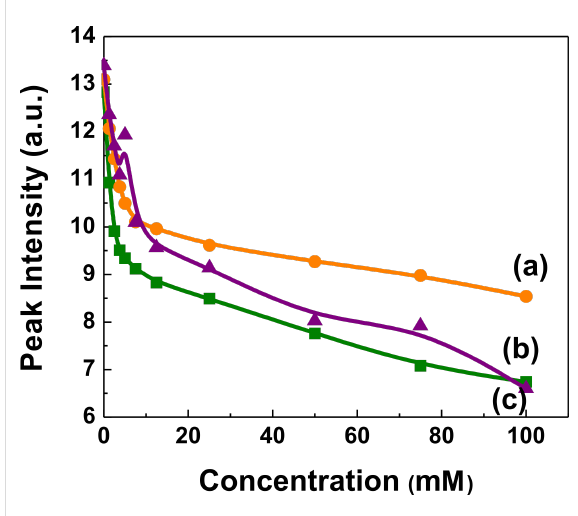
Figure 7: Stern–Volmer plots of (a–c) P3HT:CISe, P3HT:CIGSe, and P3HT:CZTSe nanocomposites. kinds of fluorophores, one of which is accessible to the quencher to a certain extent, whereas the other is inaccessible, leading to heterogeneous quenching [15,16]. This heteroge- neous quenching could be attributed to an insufficient surrounding of the surface of the large-sized nanocrystals by TOPO/TOP ligands, which failed to impose size quantization effects in these nanocrystals resulting in an enhanced size and partial accessibility of the two sets of fluorophores. This facili- tated the removal of the loosely bound TOPO/TOP ligand upon washing with the common solvents methanol and toluene and thus aided in the polymer interaction with the surface of the nanocrystals without the utilization of a ligand removal process for the replacement of the bulky TOPO/TOP ligands with the other surface-active groups. From Figure 7a–c, the calculated Stern–Volmer constants K SV values for